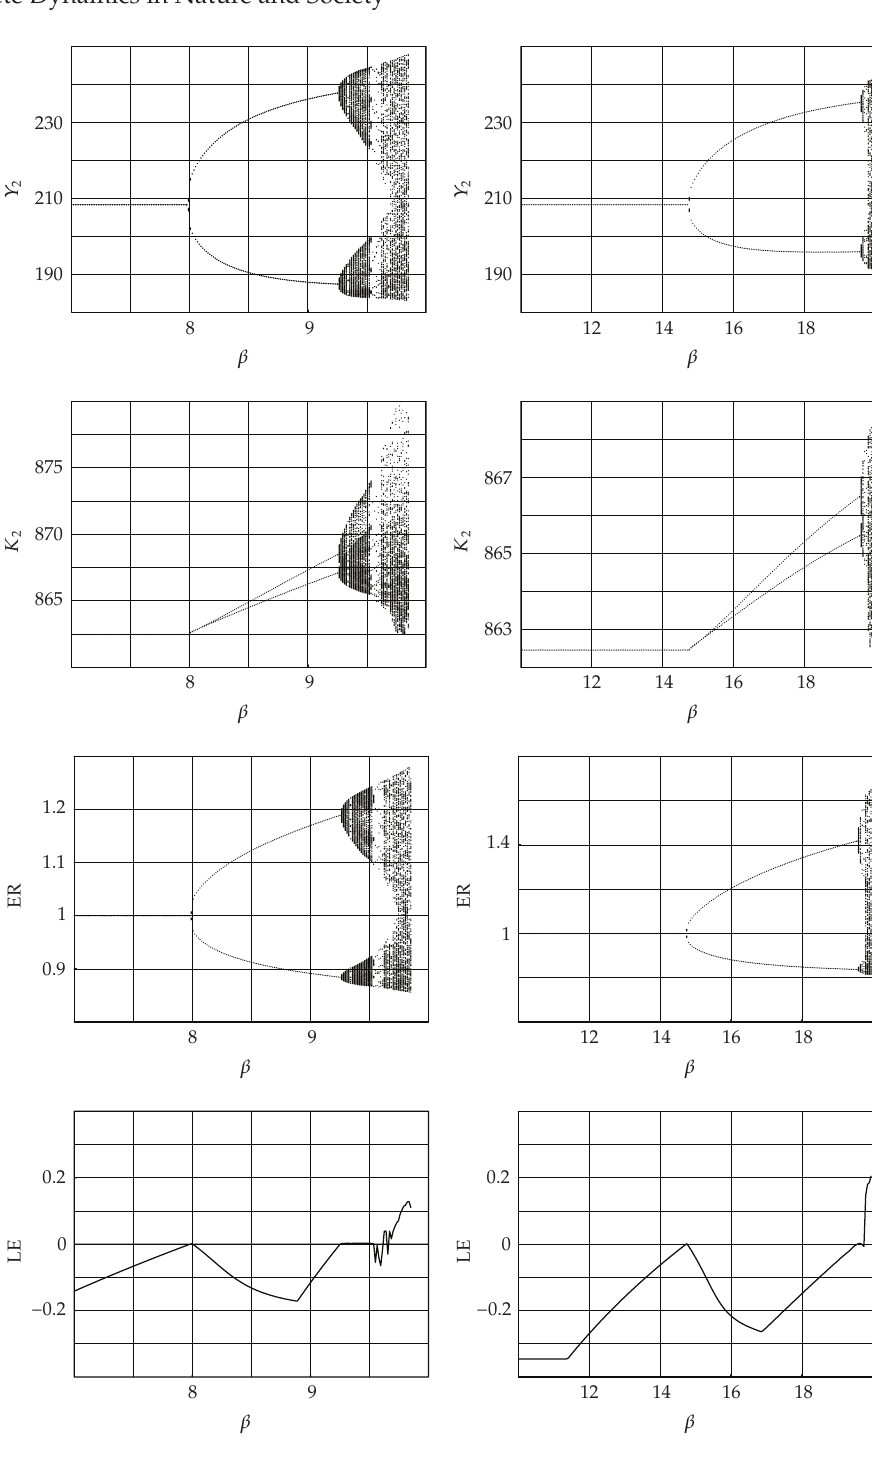
Figure 6: Bifurcation and Lyapunov exponent diagrams for δ (cid:9) 0 . 6 at: α (cid:9) 2 (cid:4) left (cid:7) , α (cid:9) 1 . 5 (cid:4) right (cid:7)